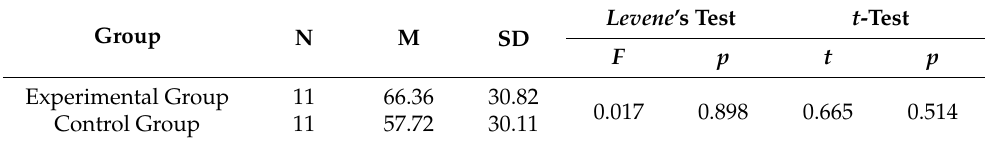
Table 1. The independent sample t -test result of the prior knowledge for the two groups. Levene ’s Test t -Test Group N M SD F p t p Experimental Group 11 66.36 30.82 57.72